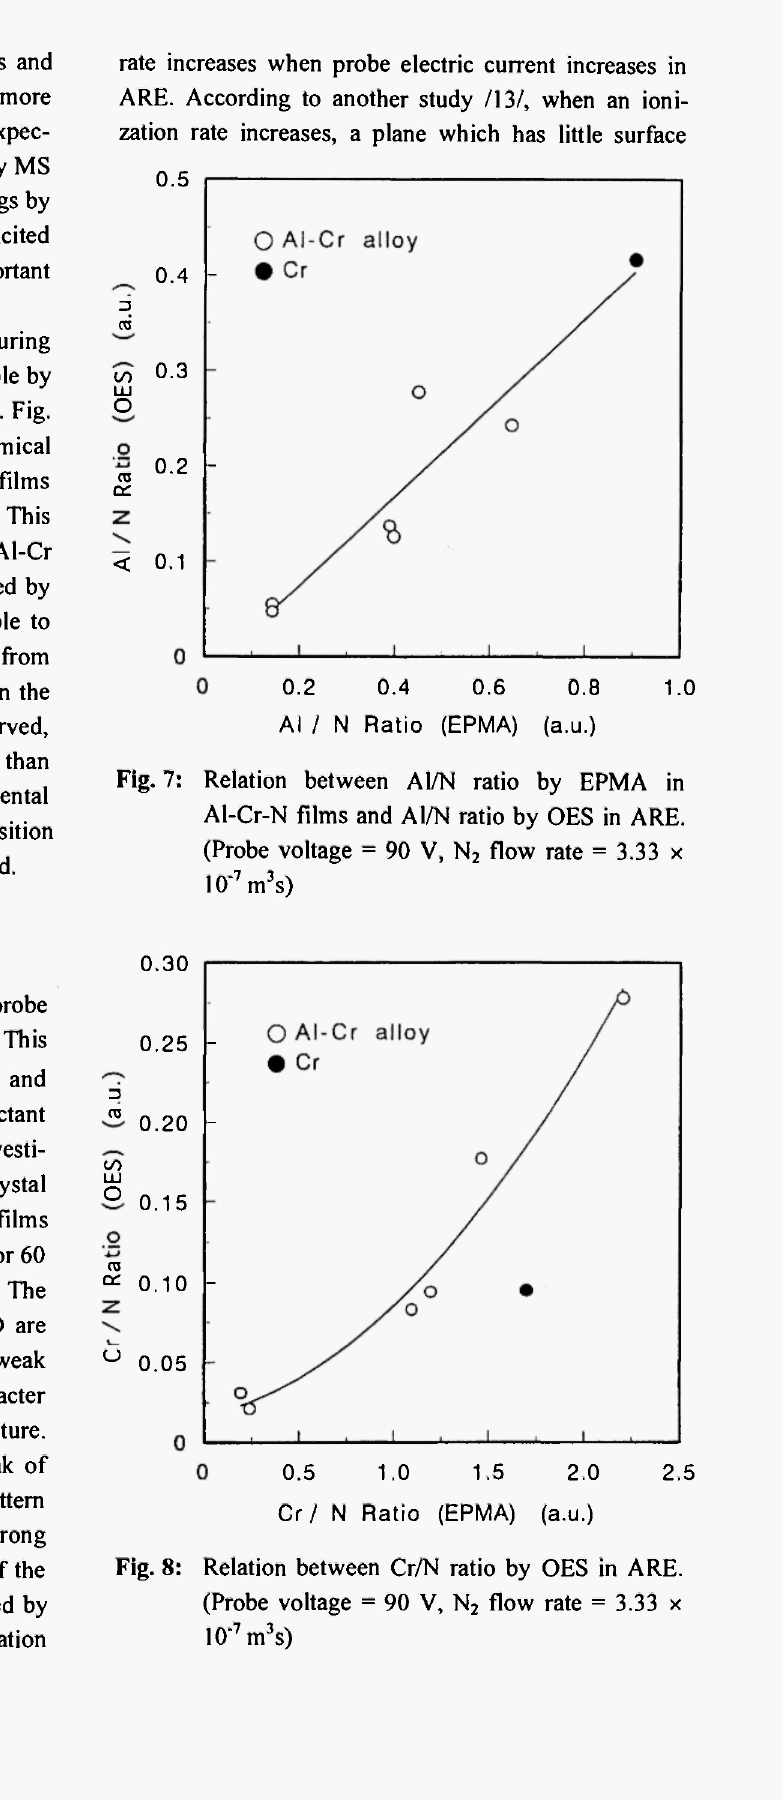
Fig. 8: Relation between Cr/N ratio by OES in ARE. (Probe voltage = 90 V, N 2 flow rate = 3.33